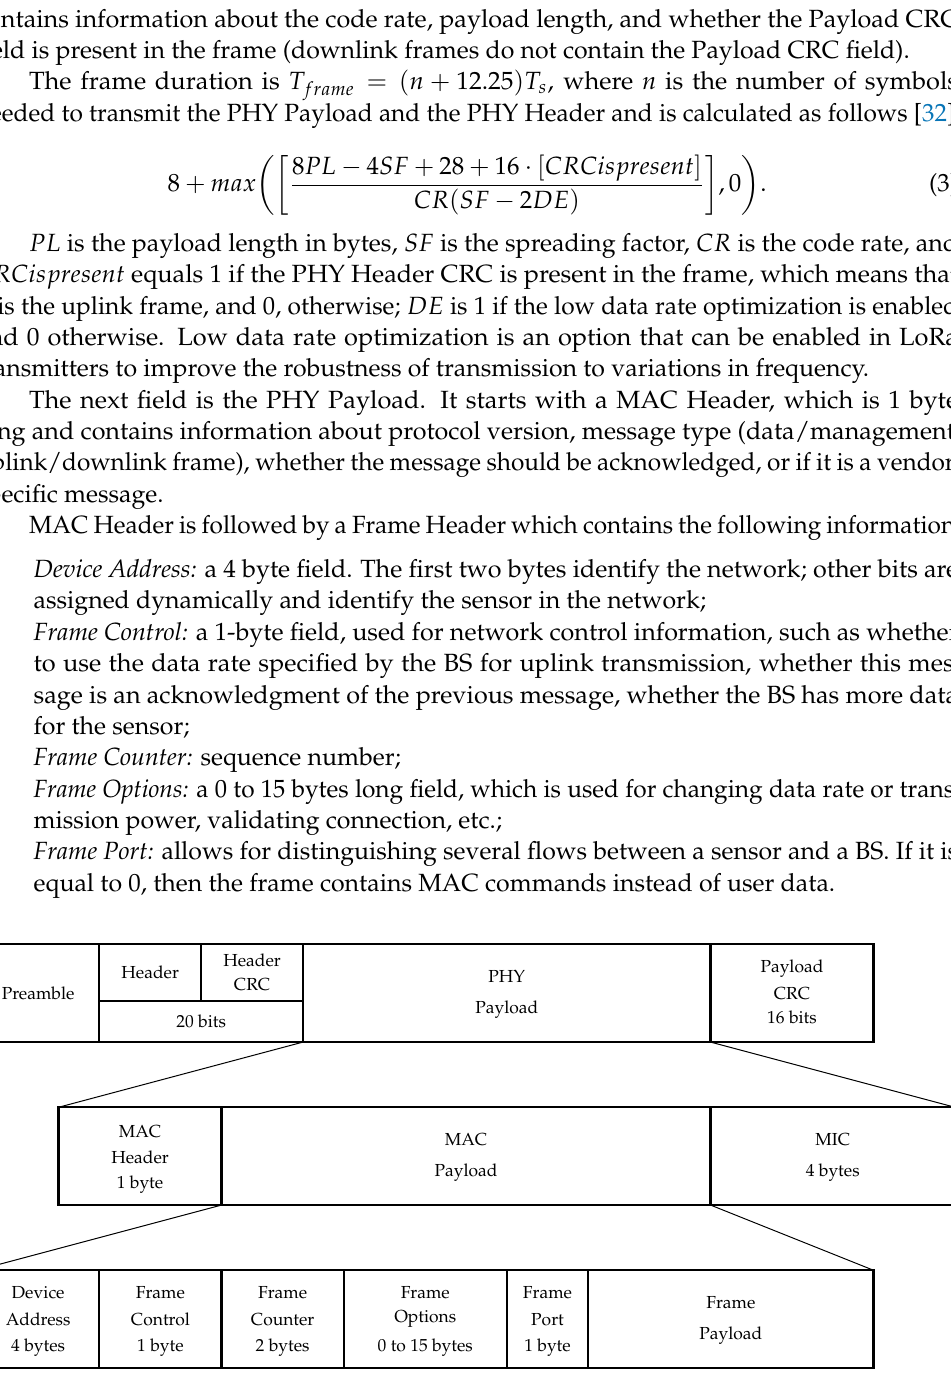
Figure 6. Uplink frame structure in